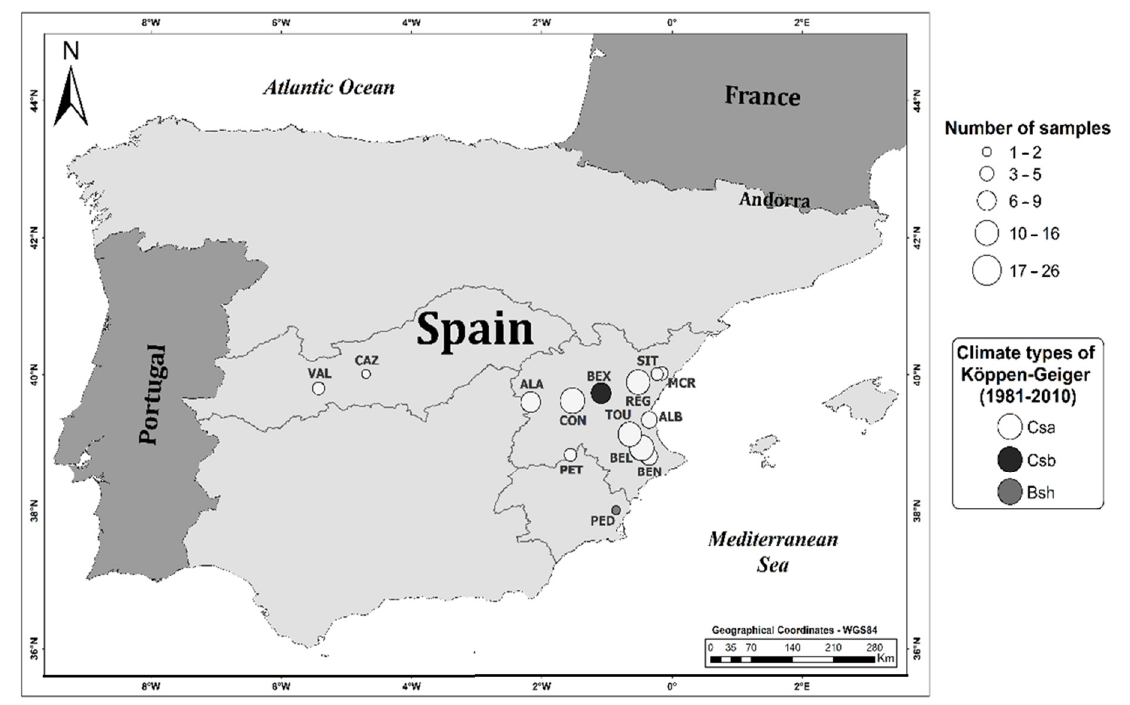
Figure 1. Location of sampled lakes and reservoirs. Symbol size reflects the number of samples col- lected at each site, and grayscale reflects the climate type.